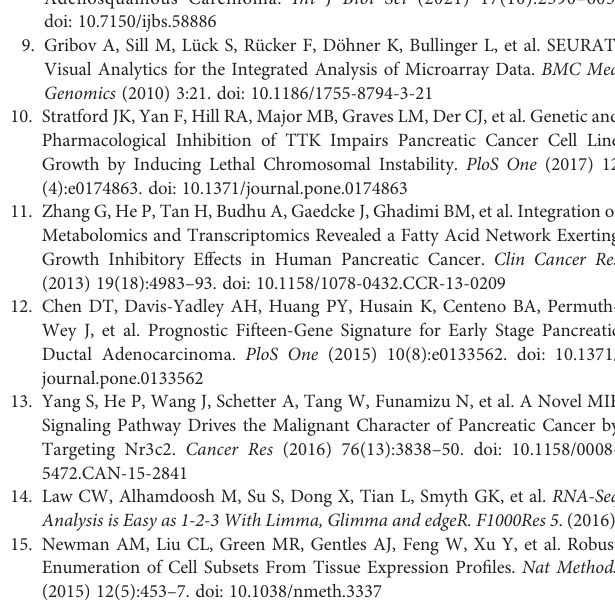
Supplementary Figure 1. | (A) A work fl ow chart of this study. (B, C) Preprocessing of single-cell data. Quality control before (B) and after (C) preprocessing. Supplementary Figure 2. | Horizontal axis indicates samples. (A) Single cell counts of raw data and clean data. (B, C) Principle component analysis (PCA) of single-cell data. PCA plots before (D) and after (E) data preprocessing in GSE cohorts. Supplementary Figure 3. | The distribution of different clinical features and MBCs in IS1 and IS2.